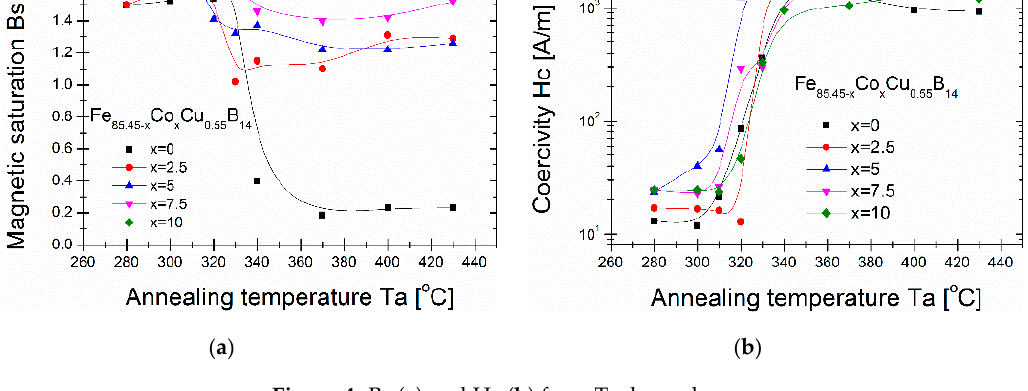
Figure 4. Bs ( a ) and Hc ( b ) from Ta dependences.